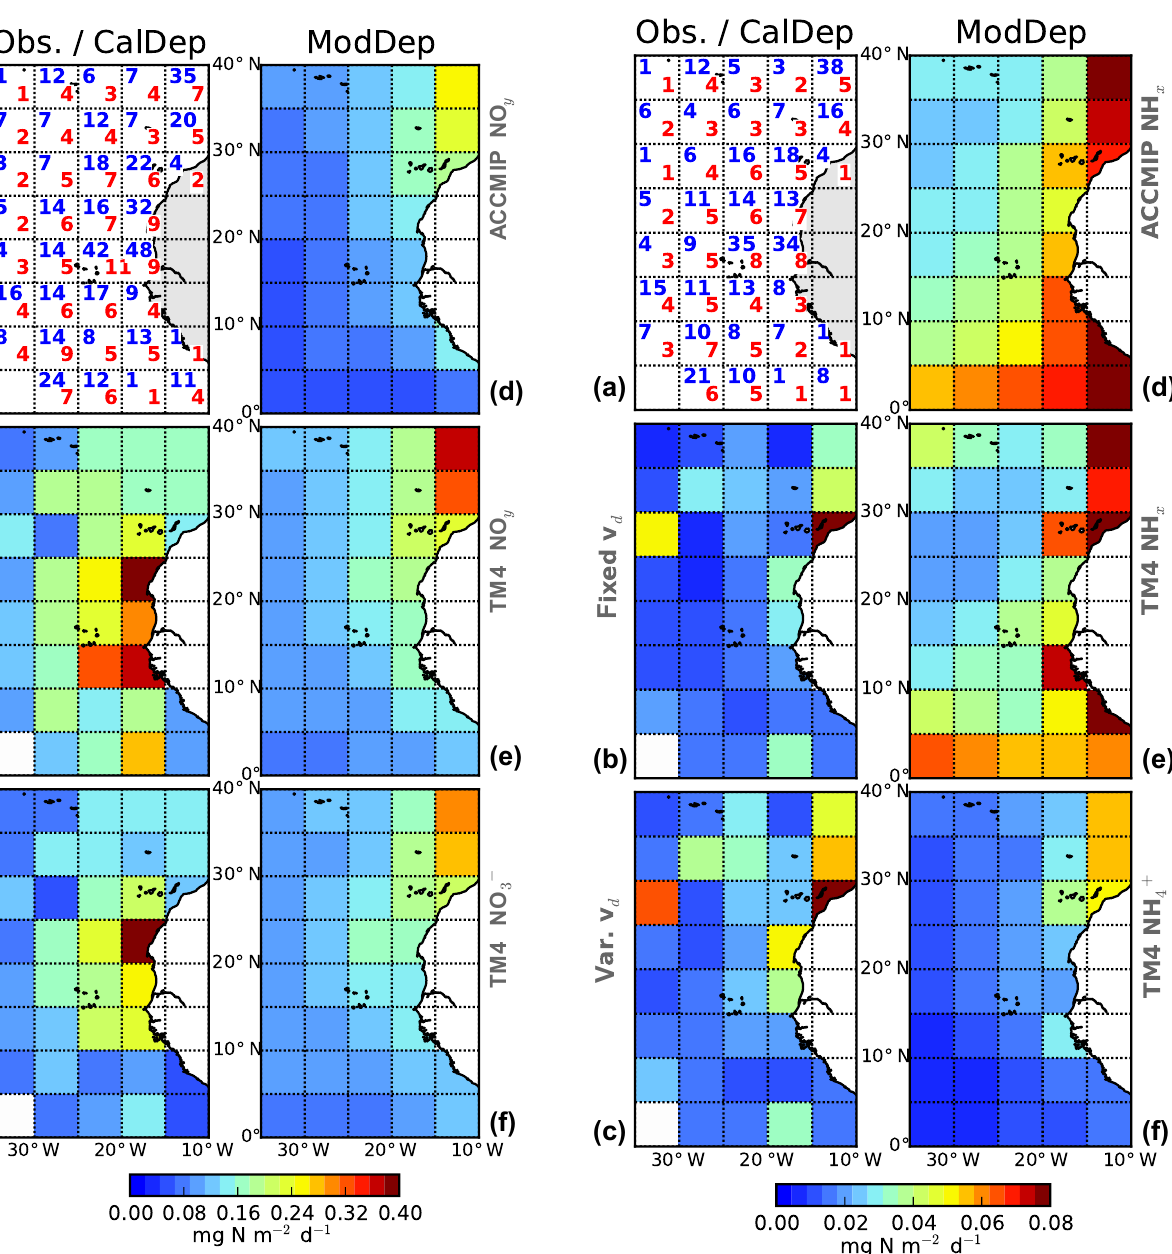
Figure 8. Dry deposition fluxes (mg Nm − 2 d − 1 ) for NO − the TEAtl region. Panels show (a) number of samples per grid cell (upper left, blue) and number of calendar months represented by observations (lower right, red), NO − (b) fixed v d and (c) variable v d methods, (d) NO y ModDep from ACCMIP, (e) NO y ModDep from TM4 and (f) NO − TM4.